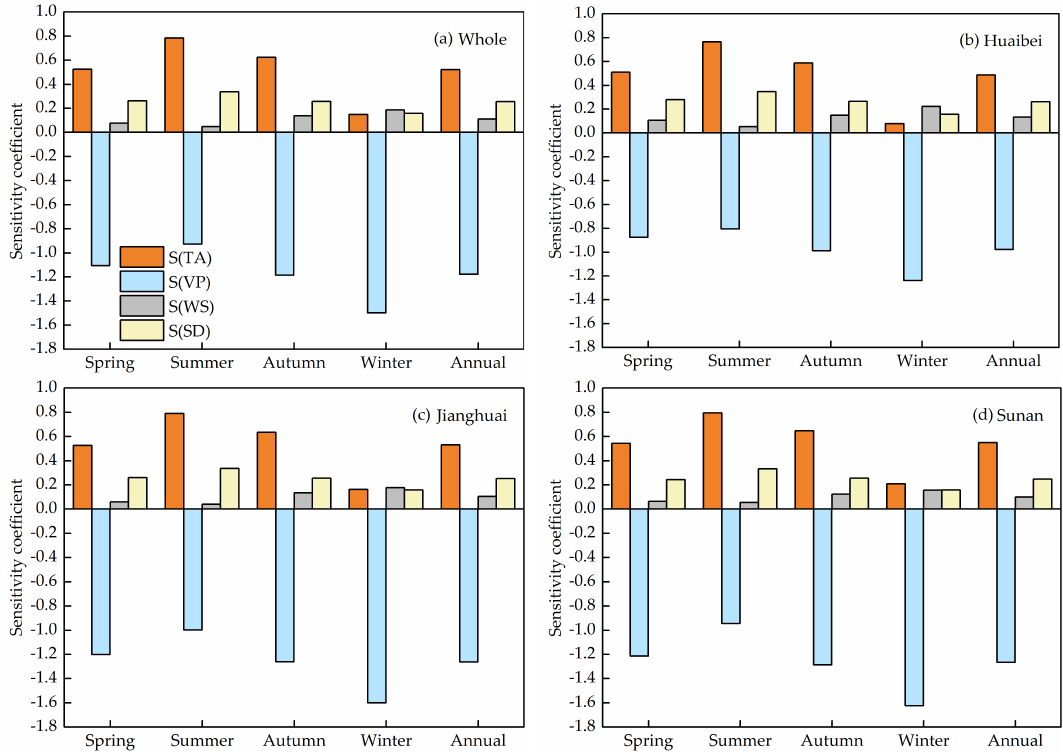
Figure 3. Sensitivities of seasonal and annual ET ref in relation to climatic factors in ( a ) Whole, ( b ) Huaibei, ( c ) Jianghuai, and ( d ) Sunan regions of the Jiangsu province from 1961 to 2015.